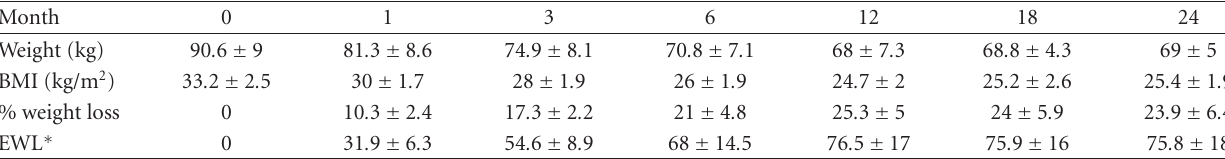
Table 3: The mean weight, mean BMI, and mean percentage of weight loss and of excess weight loss at each followup point.